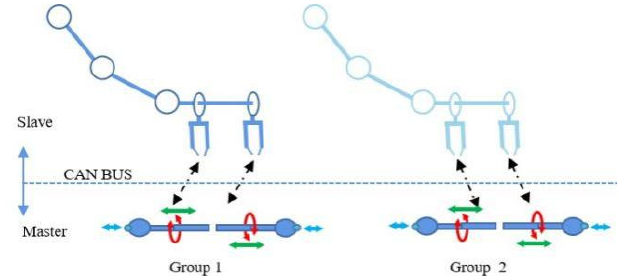
Figure 6. Master–slave operation design. The green arrows indicate that when the joystick is pulled or pushed, the slave manipulator advances or retracts. The blue arrows indicate that when the operator presses the button at the top of the joystick, the gripper clamps or releases. The red circle means that when the operator rotates the joystick, the gripper rotates.